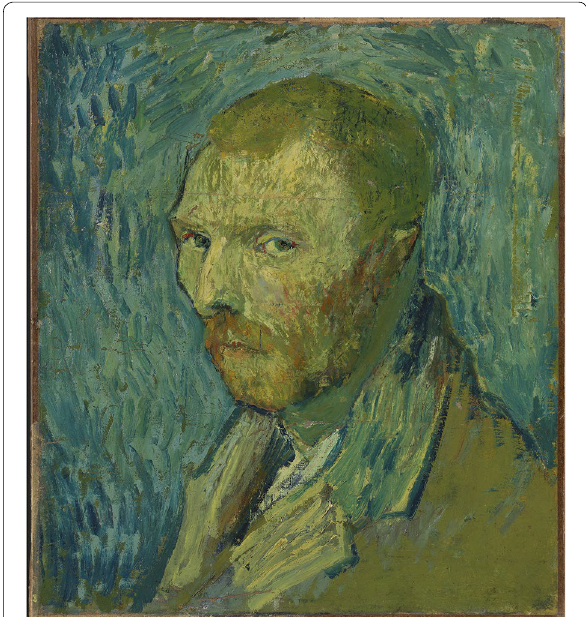
Fig. 1 Self-portrait (August 1890), Nasjonalmuseet, Oslo,